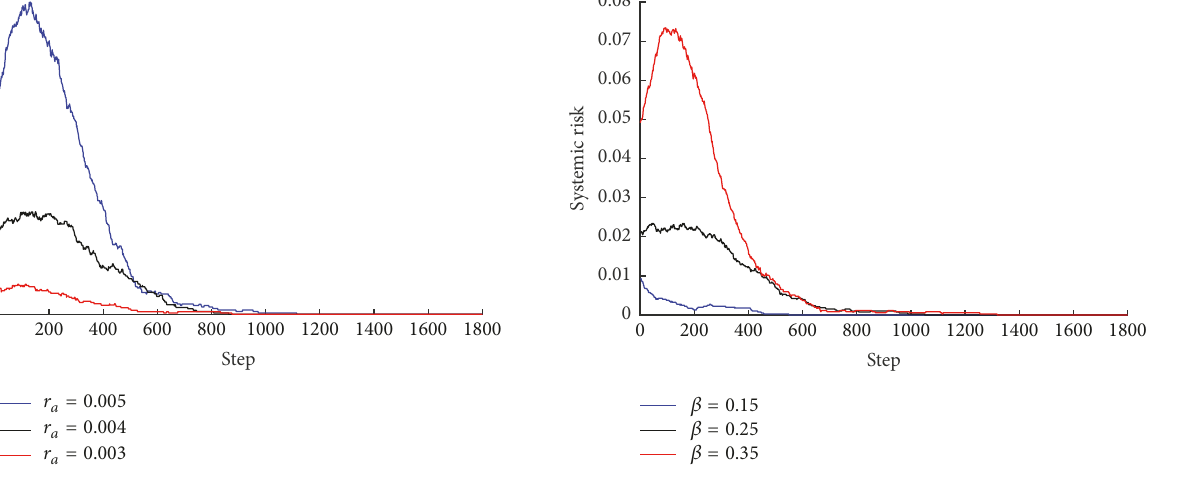
Figure 8: Systemic risk under different values of 𝑟 𝑎 . The parameters are set as 𝑑 = 0.0533 , 𝛿 𝑎 V 𝑒 = 0.009 , 𝑝 = 0.05 , 𝜃 = 0.02 , 𝐶 = 0.03 , = 0.15 , 𝜎 = 0.25 , 𝐴 = 1000 , 𝑤 = 500 , 𝜒 = 0.3 , 𝛽 = 0.25 , 𝜎 𝐴 𝑤 𝐵𝑎𝑛𝑘𝑁𝑜 = 200 , 𝐴𝑠𝑠𝑒𝑡𝑁𝑜 = 150 , and 𝑟 = 0.008 . 𝑏